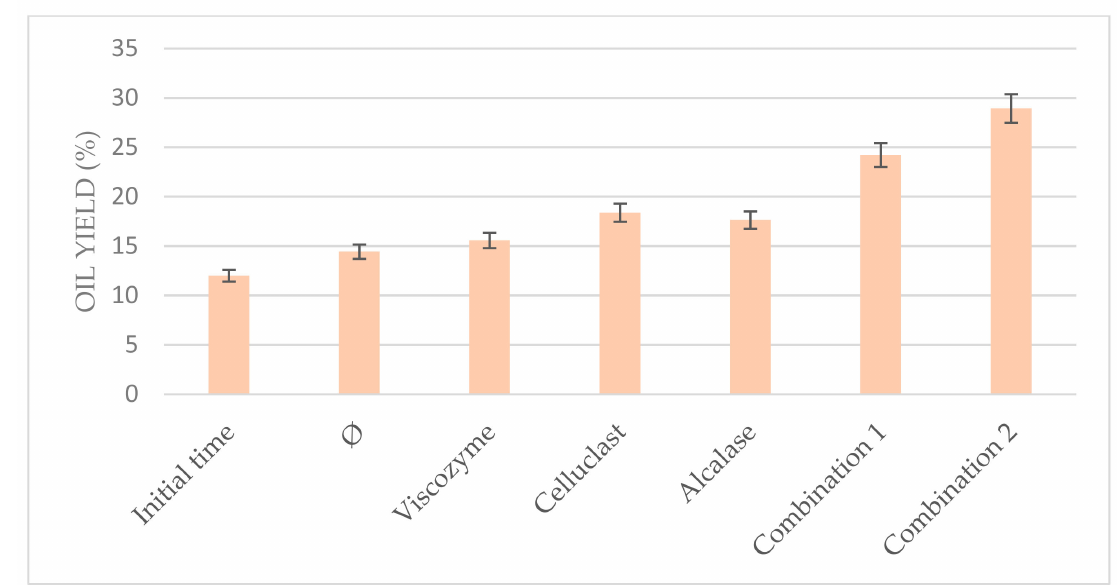
Figure 6. Nannochloropsis oil yield results using different combinations of enzymes with the US-assisted enzymatic pretreatment at the optimum conditions obtained, where Combination 1 corresponded to Celluclast+Viscozyme and Combination 2 corresponded to Celluclast + Viscozyme + Alcalase. Comparison with initial time and non-pretreated biomass (Ø) under the same conditions.